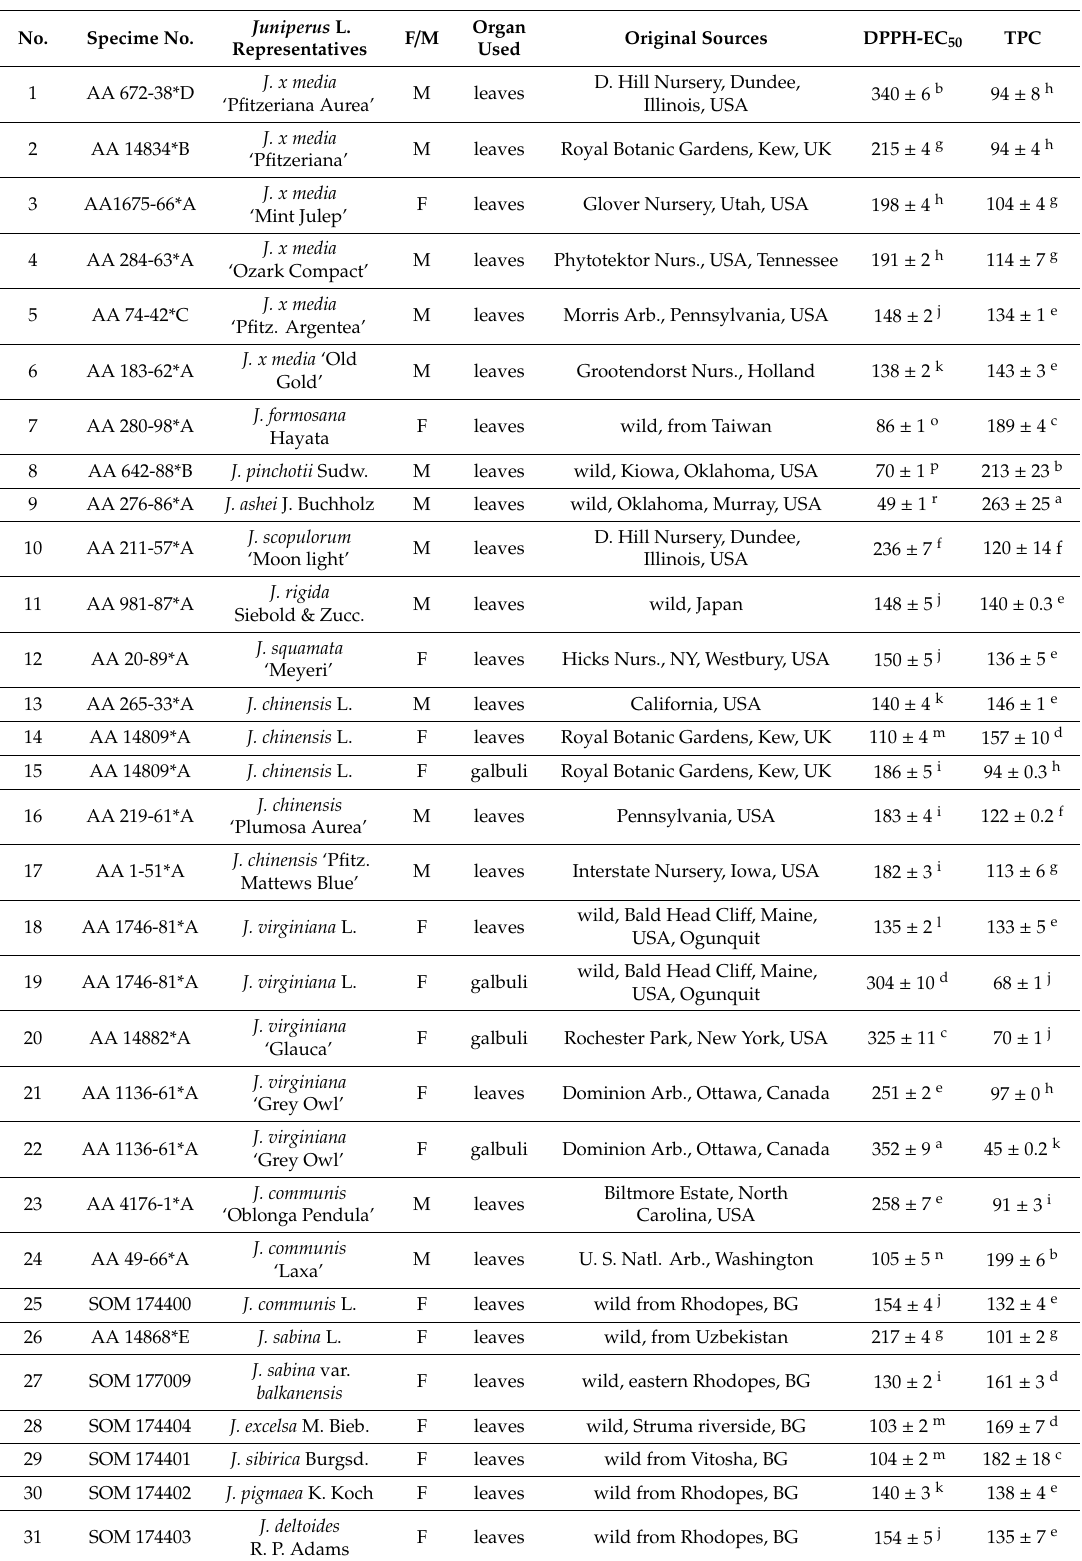
Table 1. Antioxidant activity, evaluated as half-maximum 2,2-diphenyl-1-picrylhydrazyl (DPPH)-radical scavenging concentrations (DPPH-EC 50 ) [ µ g dry extract (DE) / mL], and total polyphenols content (TPC) of the extracts [mg GAE / g